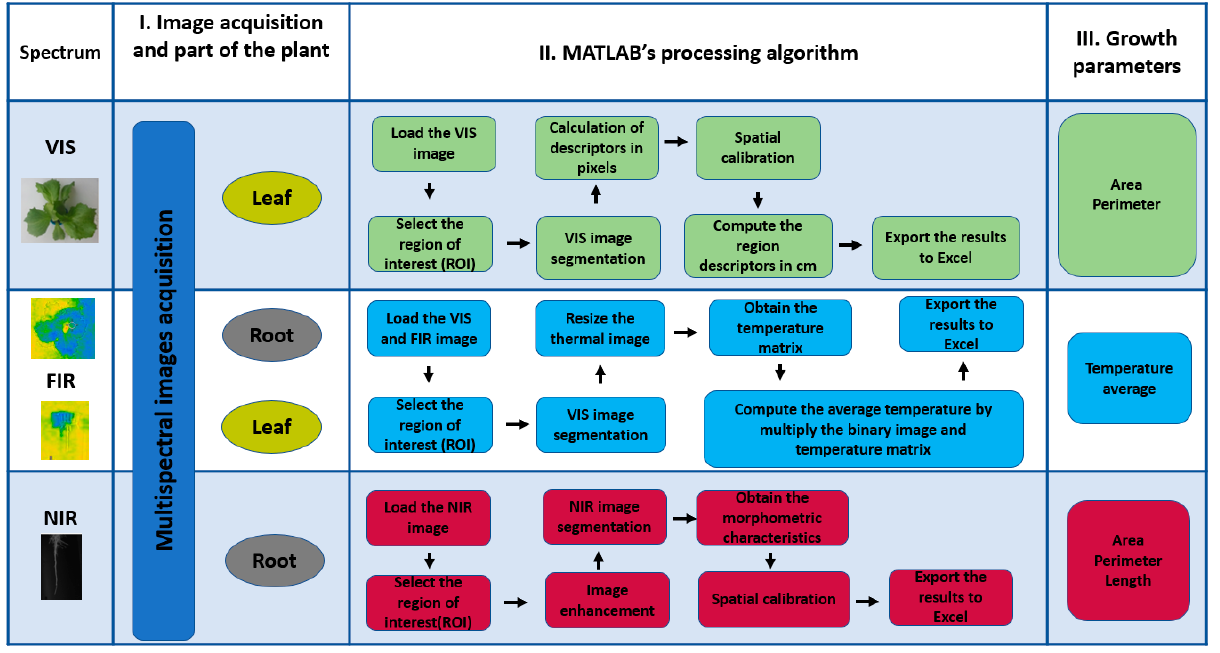
Figure 5. Flow diagram of the algorithms developed to extract growth and thermal parameters in each spectral range.